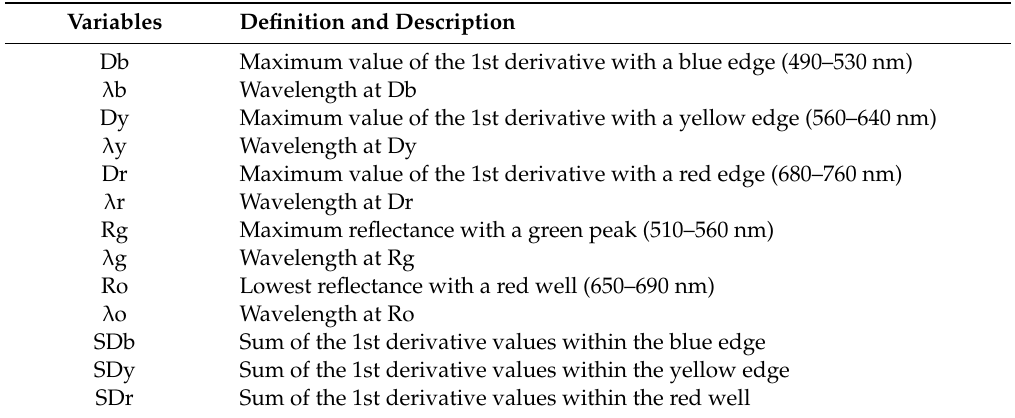
Table 2. Partial characteristic variables of the hyperspectral